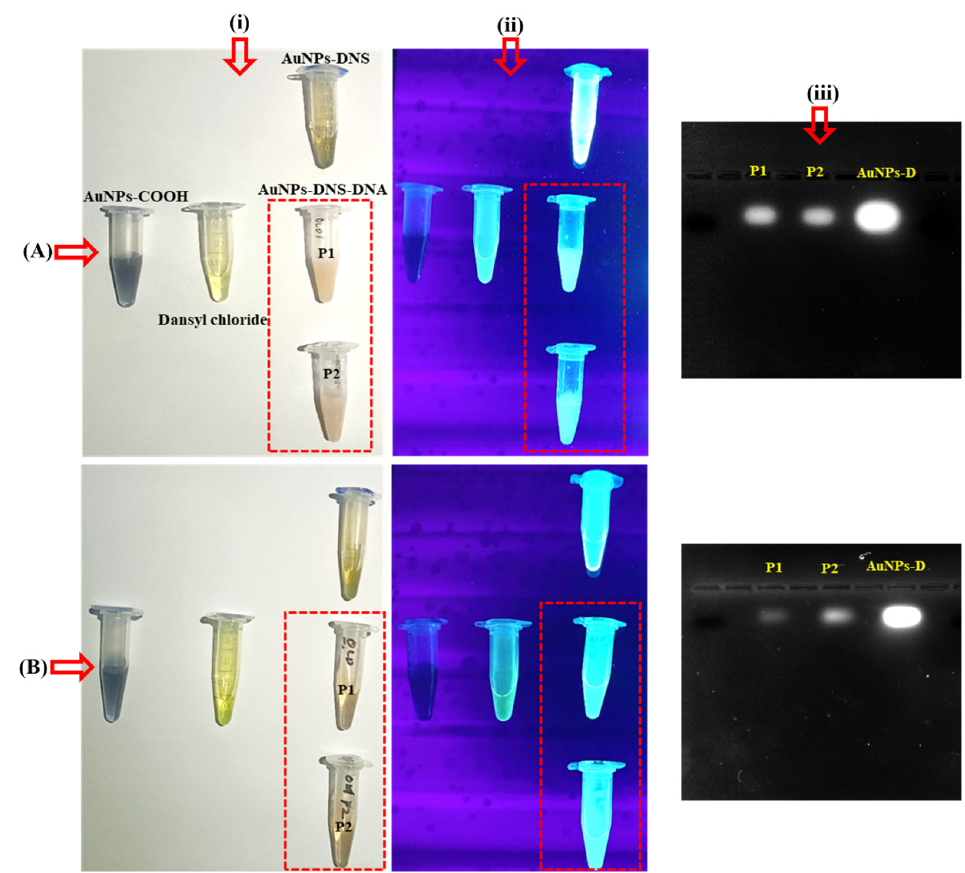
Figure 4. Images of samples after ssDNA conjugation with AuNPs-DNS. ( A ) Freeze-thaw method and ( B ) salt-aging method ( i ) daylight images, ( ii ) UV light images, and ( iii ) separation of conjugated DNA by gel electrophoresis.